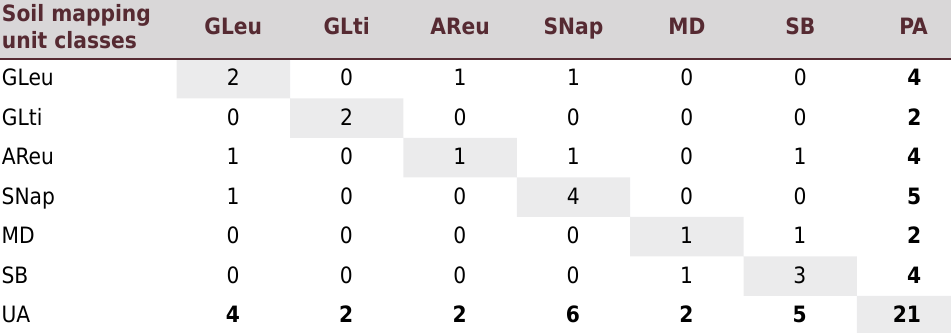
Table 4. Confusion matrix of data set 1 (field samples) Soil mapping